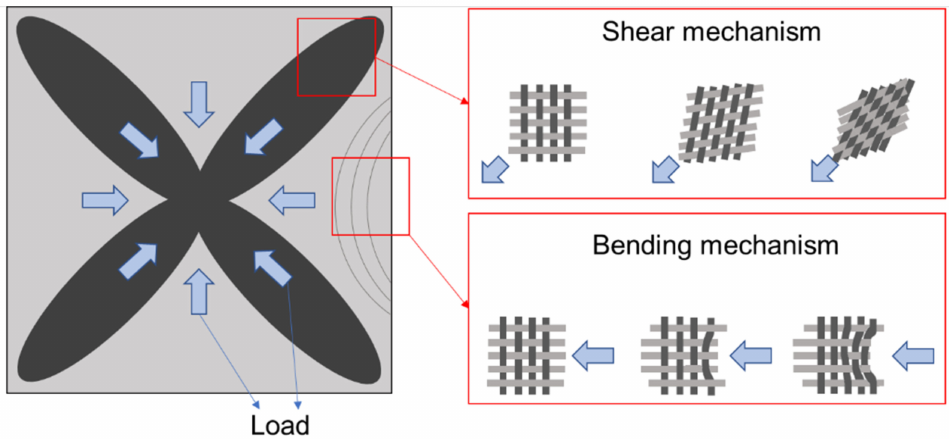
Figure 5. Load distribution during drapability test—fiber shear and bending